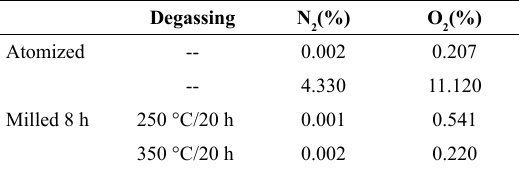
Table 4. Nitrogen and oxygen contents in atomized samples, milled for 8 h in cryogenic atmosphere and